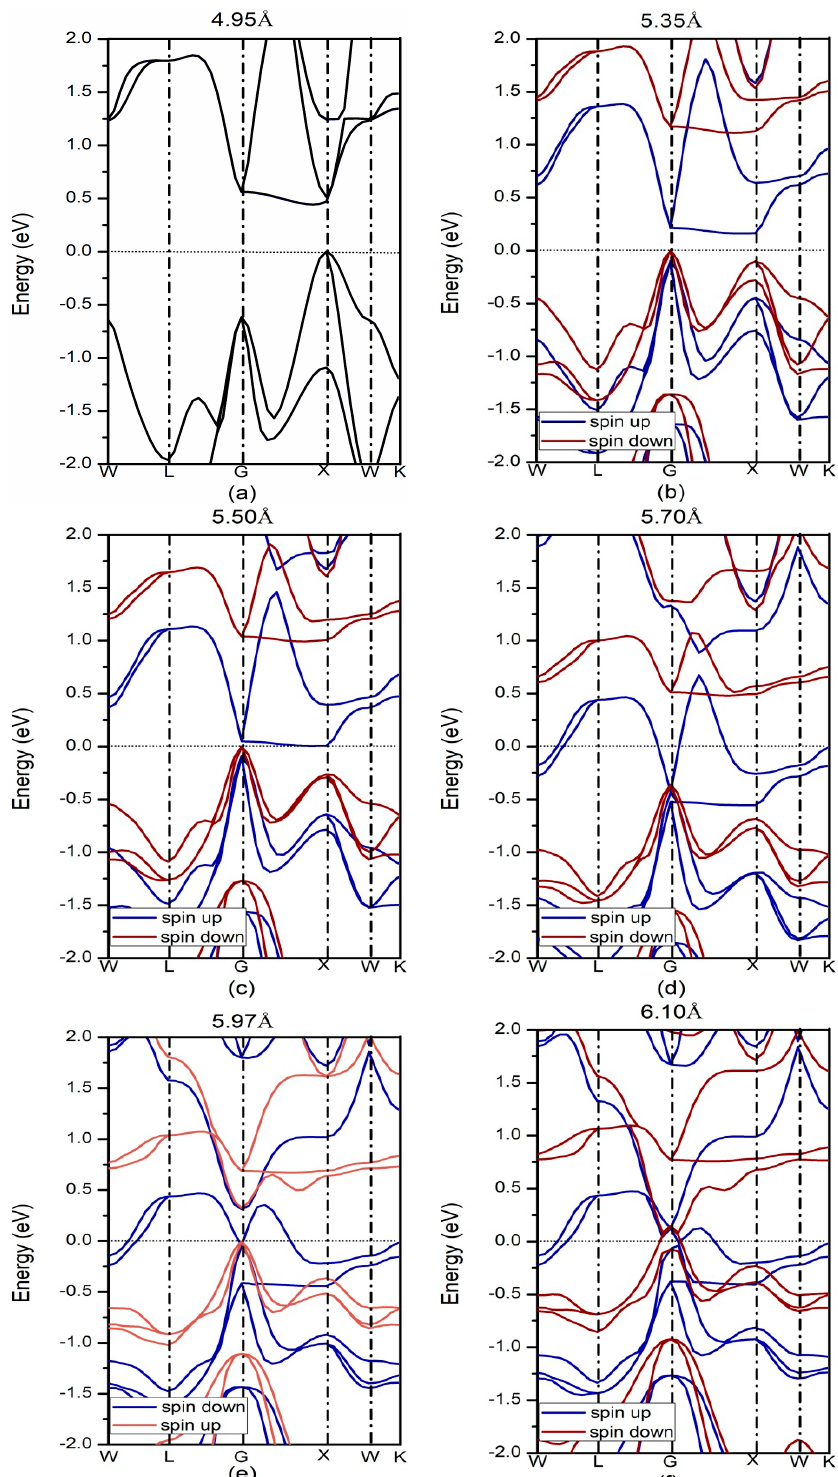
Figure 8. ( a – f ) are band structures under strained lattice constants of 4.95 Å, 5.35 Å, 5.50 Å, 5.70 Å, 5.97 Å, and 6.10 Å, respectively, for ScFeRhP compound. 5.97 Å, and 6.10 Å, respectively, for ScFeRhP